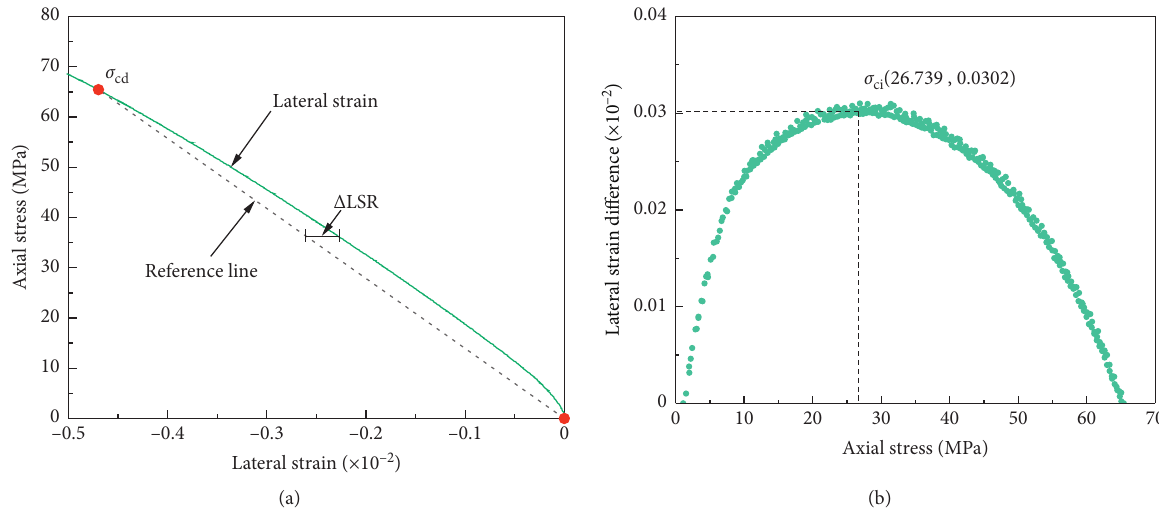
Figure 10: Determination of initiation stress using lateral strain response method. (a) Lateral strain difference of coal rock. (b) Deter- mination of initiation